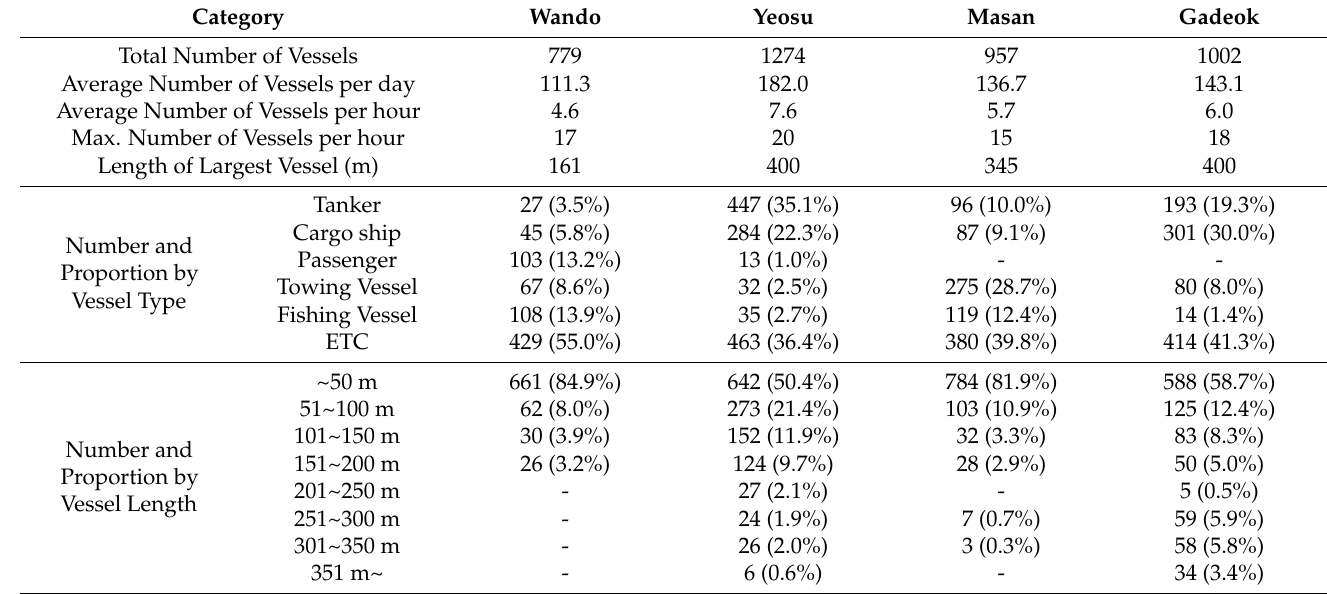
Table 4. Results of maritime traffic survey by target